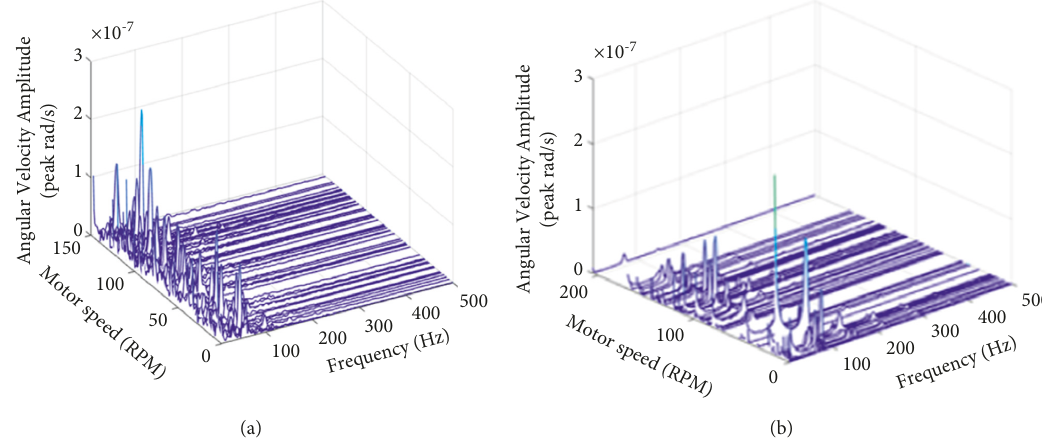
Figure 10: Driveshaft frequency representation of angular velocity during acceleration of the unbalanced and cracked system at 1447.74rpm. (a) without fluid and (b) with a viscous